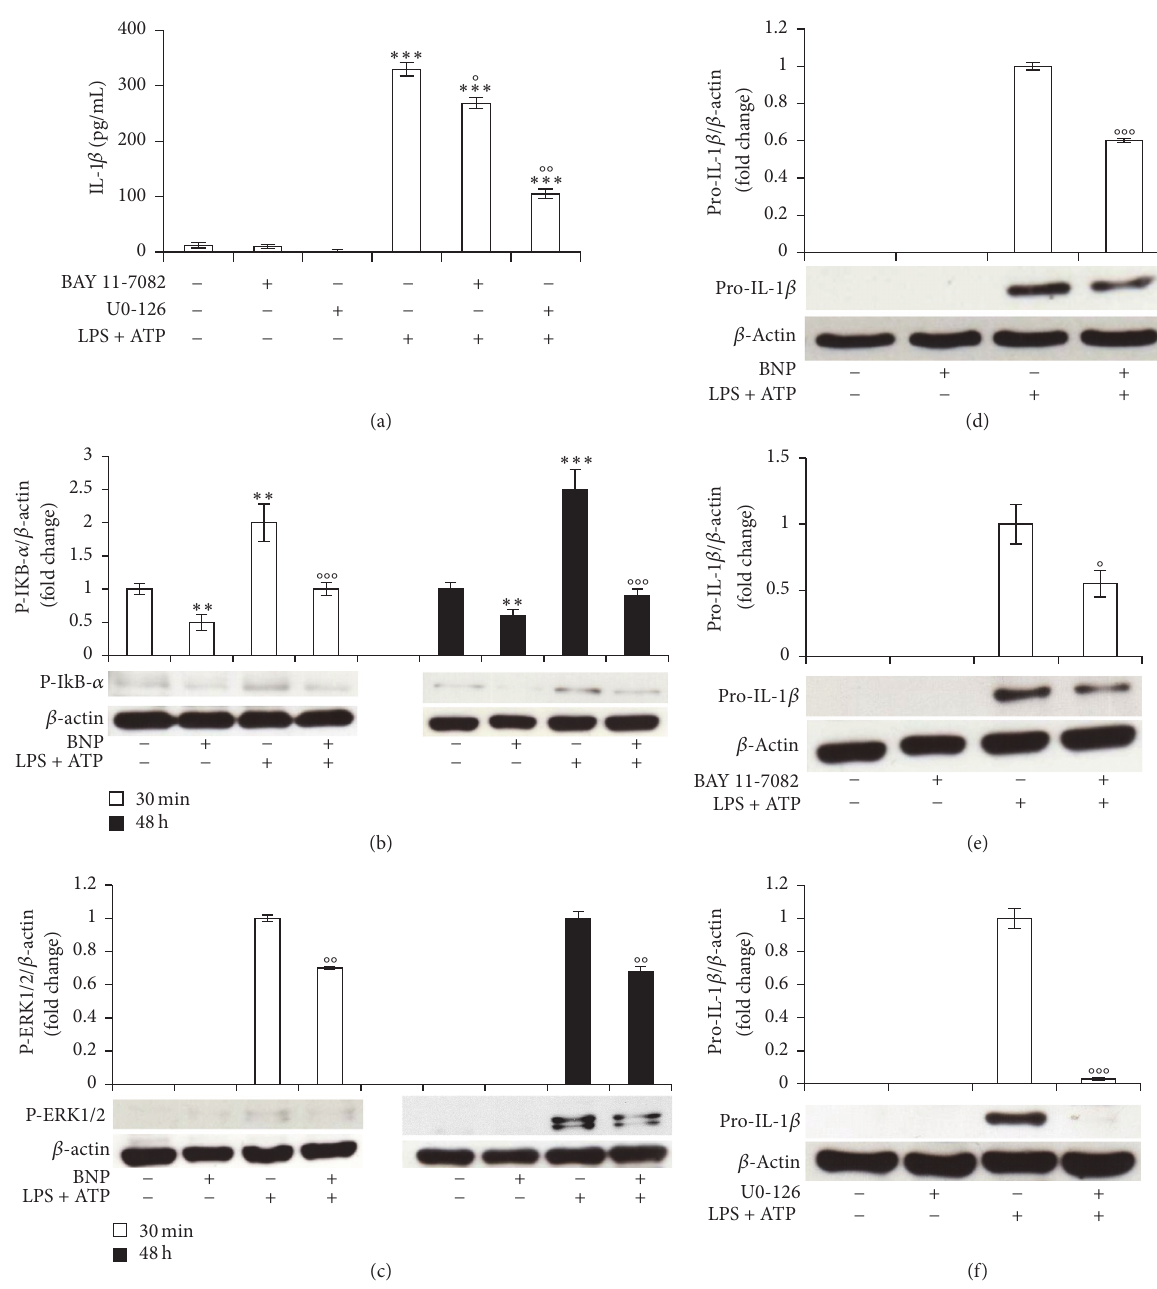
(c)00.20.40.60.811.2 Figure 3: BNP is involved in the priming mechanism controlling IL-1 𝛽 production by inhibiting NF-kB and ERK 1/2 activation in THP-1 cells. (a) THP-1 cells were incubated with 10 𝜇 M BAY 11-7082 or U0-126 for 1h and then treated with 10 𝜇 g/mL LPS/5 mM ATP for 48 h. The supernatants were collected and IL-1 𝛽 release was measured by ELISA. (b, c, d) THP-1 cells were treated with 10 −8 M BNP in absence or presence of 10 𝜇 g/mL LPS/5 mM ATP for 30min (b, c) or 48 h (b, c, d). Cell lysates were immunoblotted for P-IkB- 𝛼 (b), P-ERK 1/2 (c), or pro-IL-1 𝛽 (d). (e, f) THP-1 cells were incubated with 10 𝜇 M BAY 11-7082 (e) or U0-126 (f) for 1 h and then treated with 10 𝜇 g/mL LPS/5mM ATP for 48h. Cell lysates were immunoblotted for pro-IL-1 𝛽 . The blots were stripped of the bound Ab and reprobed with mouse anti- 𝛽 -actin, to confirm equal loading. Western blots are representative of three separate experiments. All histograms indicate means ± SD of three separate experiments each one tested in triplicate. ∗∗ 𝑃 < 0.01 and ∗∗∗ 𝑃 < 0.001 versus untreated cells and ∘ 𝑃 < 0.05, ∘∘ 𝑃 < 0.01, and ∘∘∘ 𝑃 < 0.001 versus LPS/ATP treated